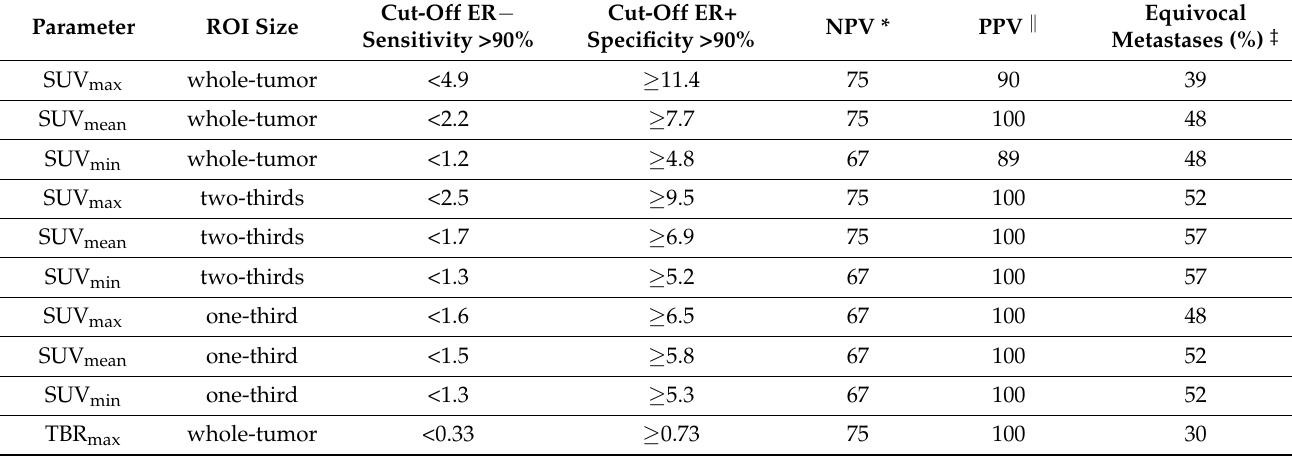
Table 3. PET parameters and cut-off values to determine ER status by [ 18 F]-FES-PET ( n = 23).